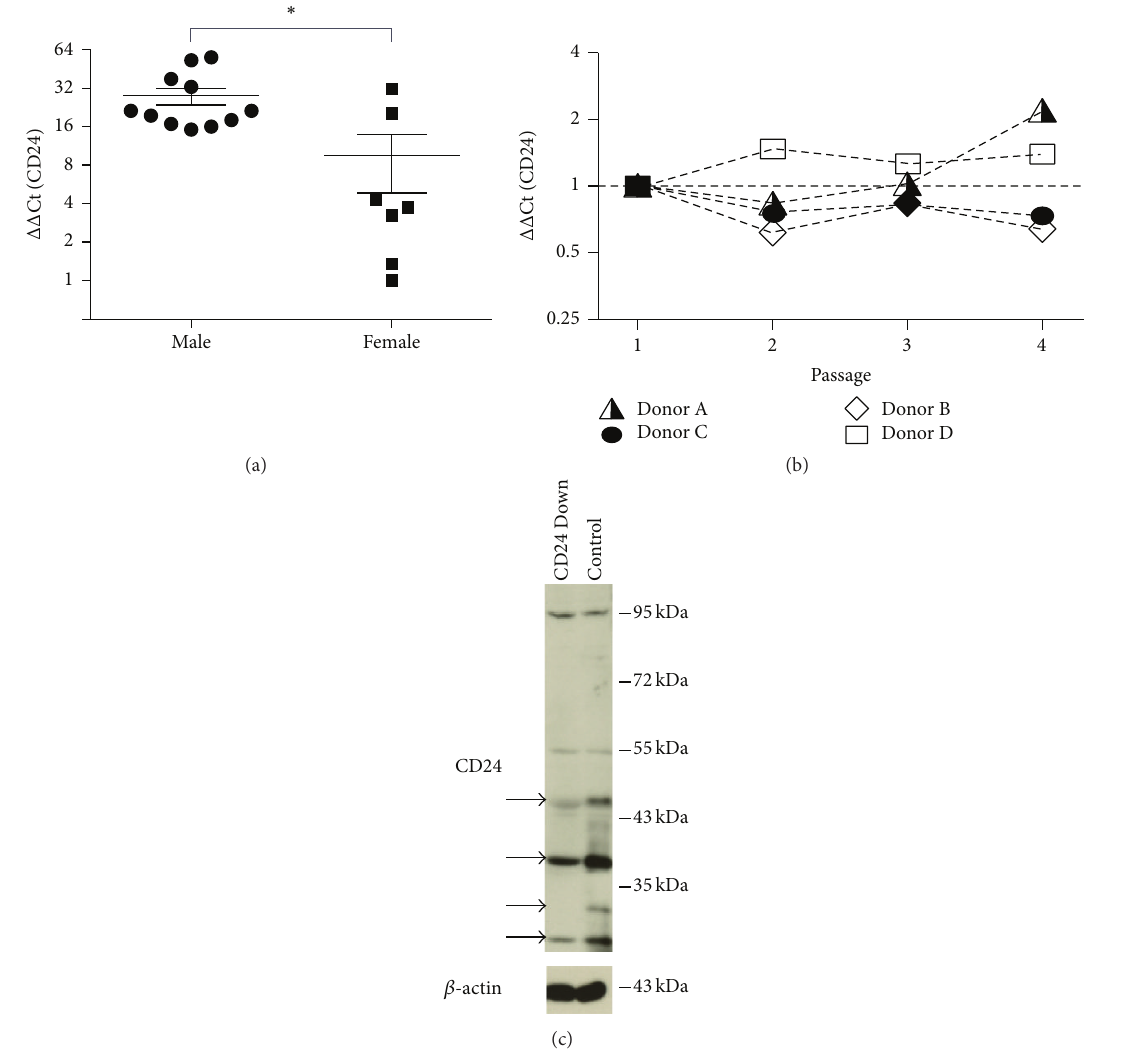
Figure 1: Analysis of CD24 expression in hBMSCs. (a) hBMSC mRNA from 18 different donors in passage 2 of in vitro culture were analyzed for the expression of CD24 mRNA by qRT-PCR and analyzed for gender-dependent differences in mRNA expression levels. The relative expression values are plotted as fold change in mRNA expression ( ΔΔ Ct) relative to the sample with the lowest relative CD24 mRNA expression. (b) The mRNA expression of CD24 was analyzed from passage 1 to passage 4 of in vitro culture in 4 individual donors. The expression values are normalized to the expression levels of the respective donor in passage 1 ( ΔΔ Ct). (c) The expression of CD24 protein was evaluated by western blot with a polyclonal rabbit anti-CD24 antibody. In order to determine which bands were specific for CD24 hBMSCs were transduced with either a shRNA directed against CD24 mRNA (CD24 Down) or a scrambled shRNA (Control). Cell extracts from these two groups were then compared for CD24 reactive bands: the western blot bands with reduced intensity in the CD24 Down Group are marked with black arrows and represent bands specific for CD24. 𝛽 -actin was used as loading